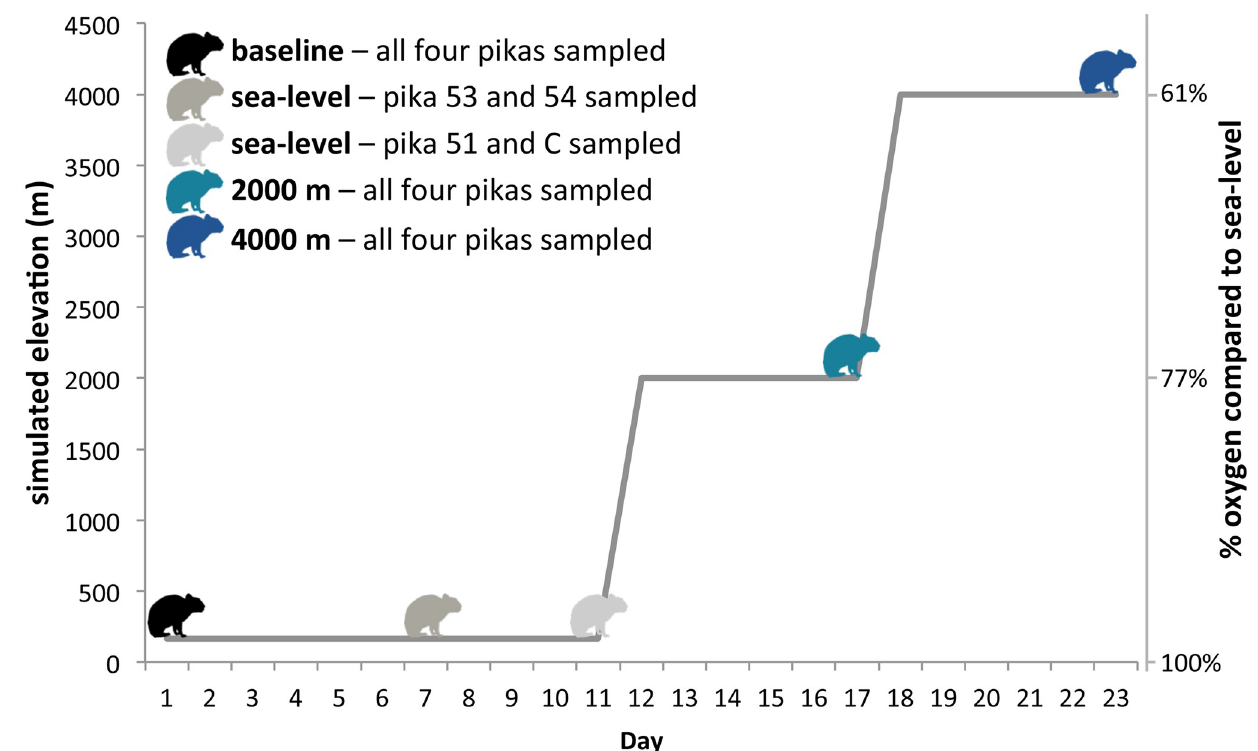
Fig 2. Sampling scheme indicating the simulated elevation and denoting when blood samples were